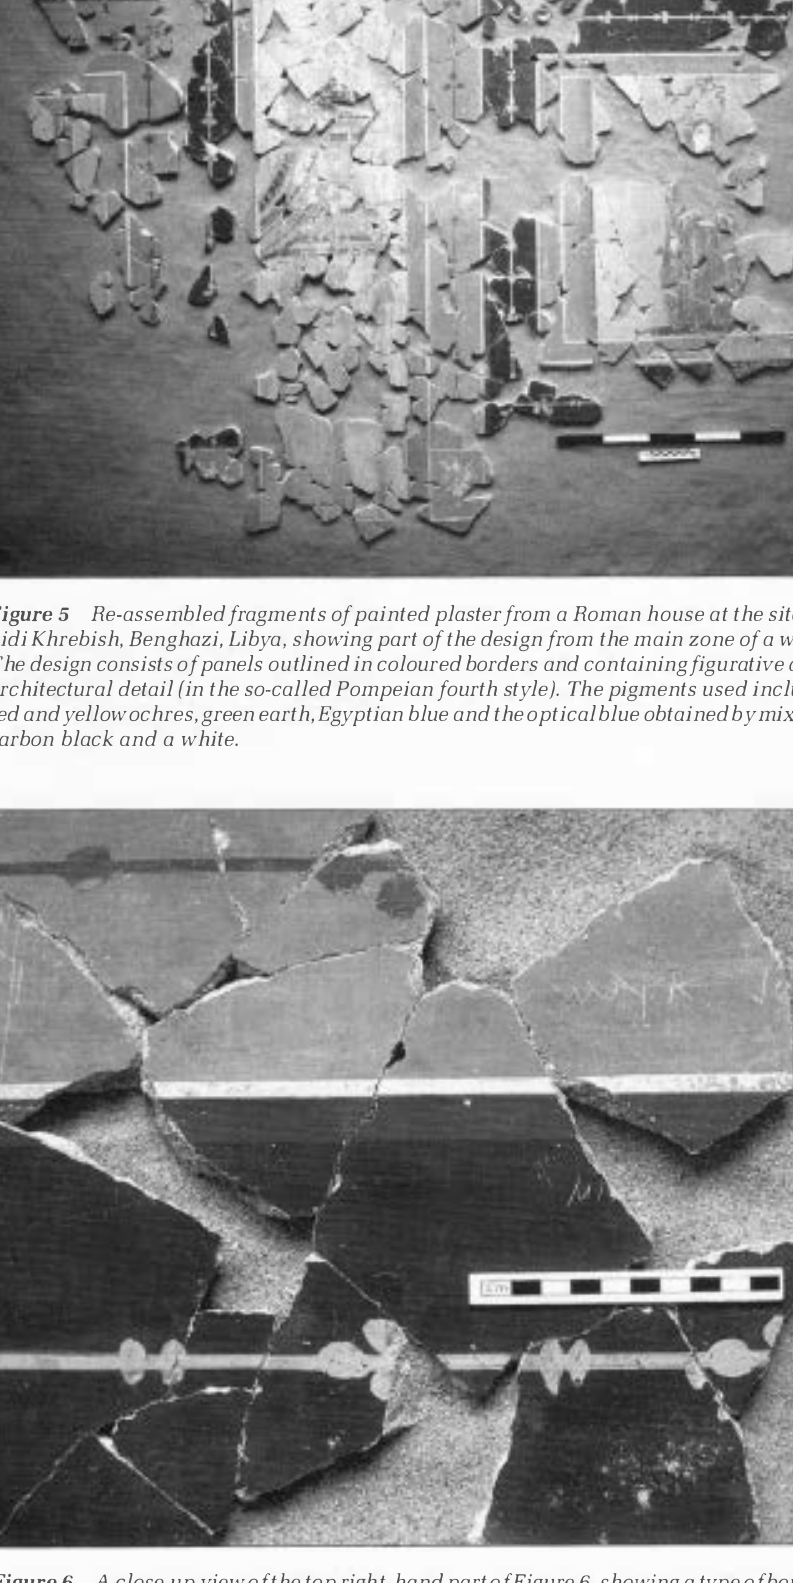
A close-up view of the top right-hand part of Figure 6, showing a type of border design used vezy widely in Roman wall painting; later Roman graffiti can be seen on the top-right fragment above the white